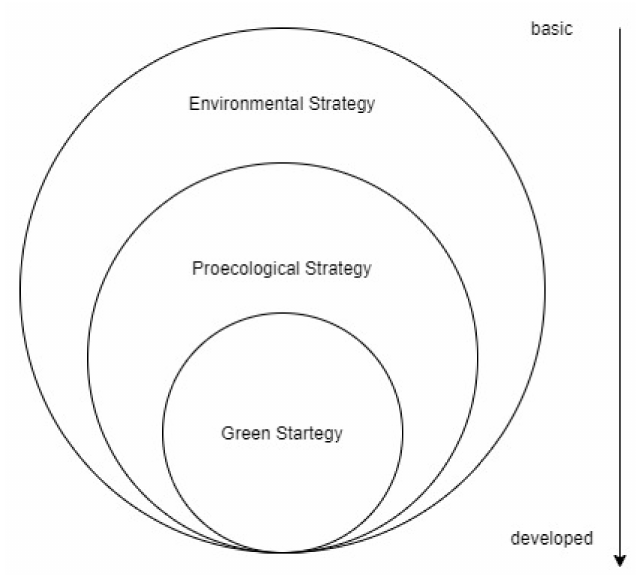
Figure 1. Relationship between sustainability strategies and management approaches. Source Authors’